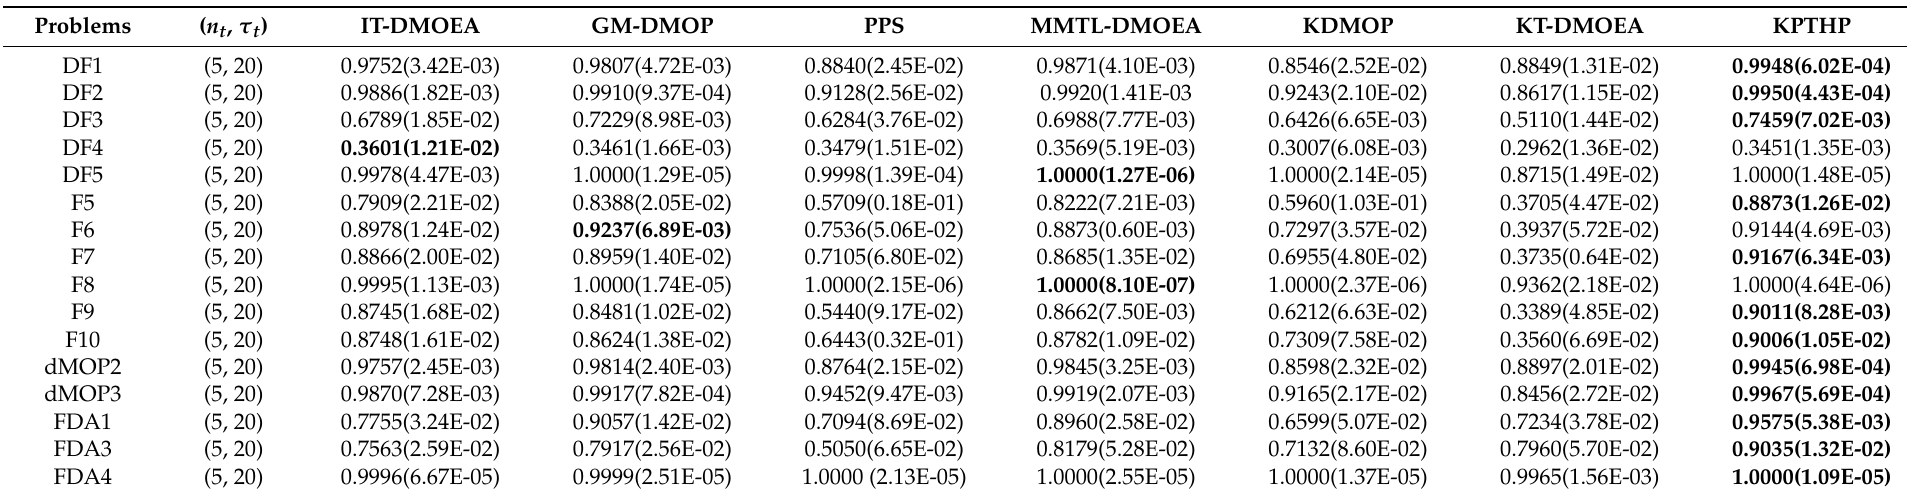
Table 4. Mean and SD of MMS indicator obtained by seven algorithms for ( n t , τ t ) = (5,